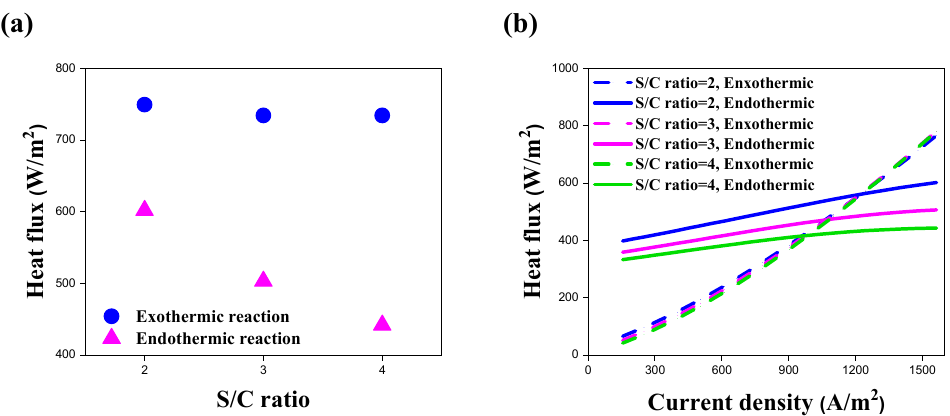
Figure 15. Heat flux of the exothermic and endothermic reactions according to S/C ratios ( a ) at 1500 A/m 2 and ( b ) the current density.